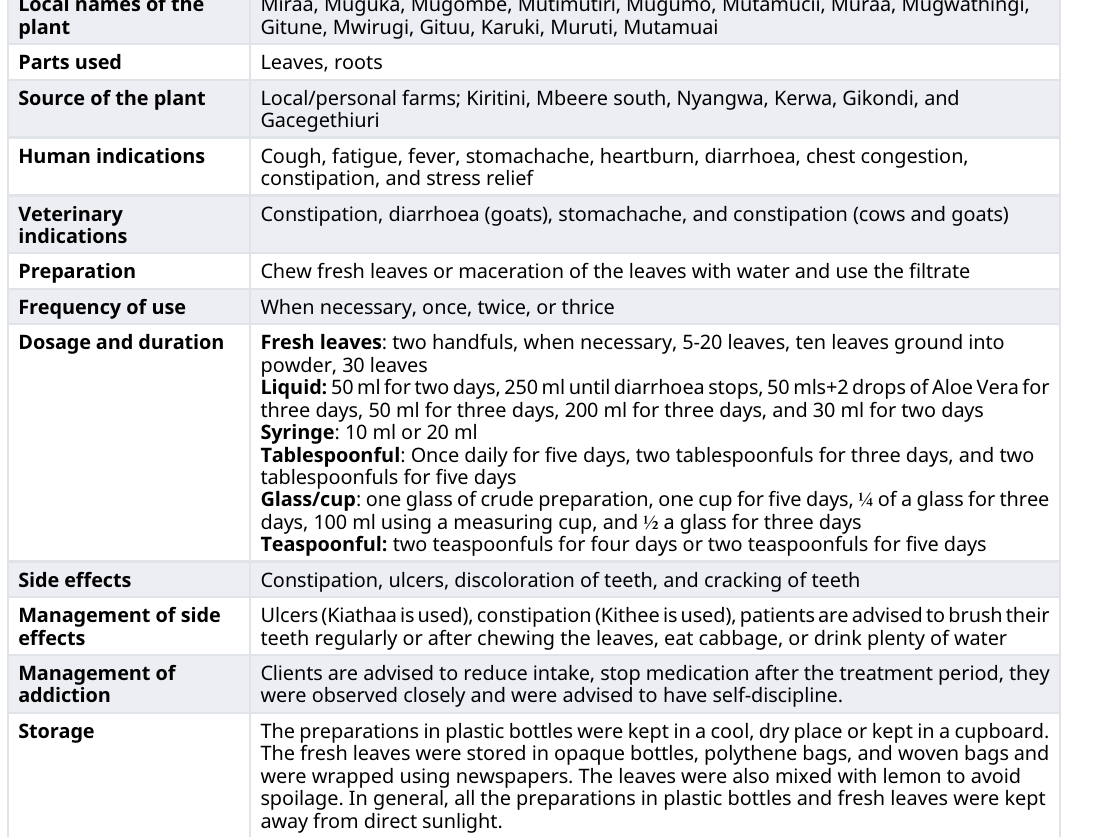
Table 2. Local names, parts used, sources, indications, preparation, frequency of use, dosage and duration, side effects, and storage of Catha edulis (Vahl.) Endl. Local names of the